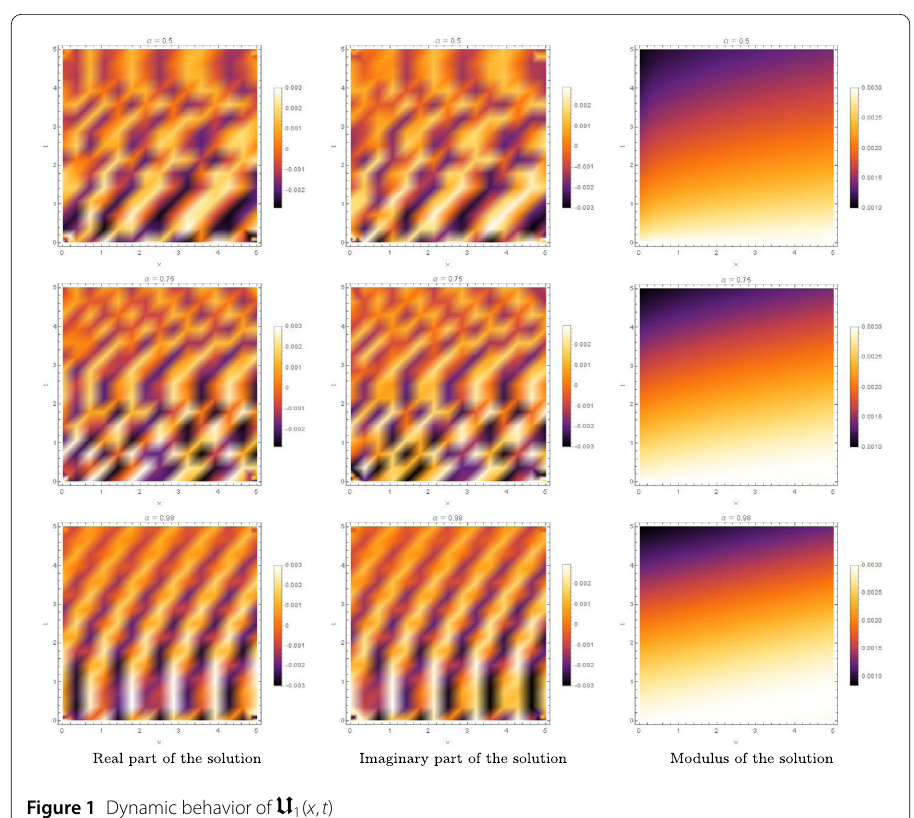
Figure 1 Dynamic behavior of U 1 ( x , t